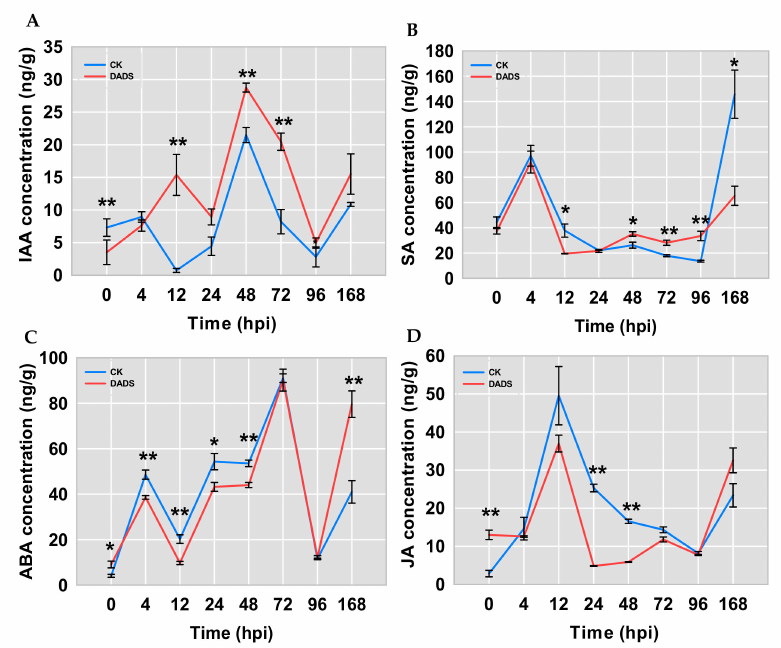
Figure 3. Comparisons of the IAA ( A ), ABA ( B ), SA ( C ), and JA ( D ) content in DADS-treated and CK leaves with P. cubensis infection. Data are means ± standard errors (n = 3, three biological replicates). Asterisks indicate significant differences between the DADS treatment and CK (* p < 0.05; ** p < 0.01) based on a one-way ANOVA followed by a t −